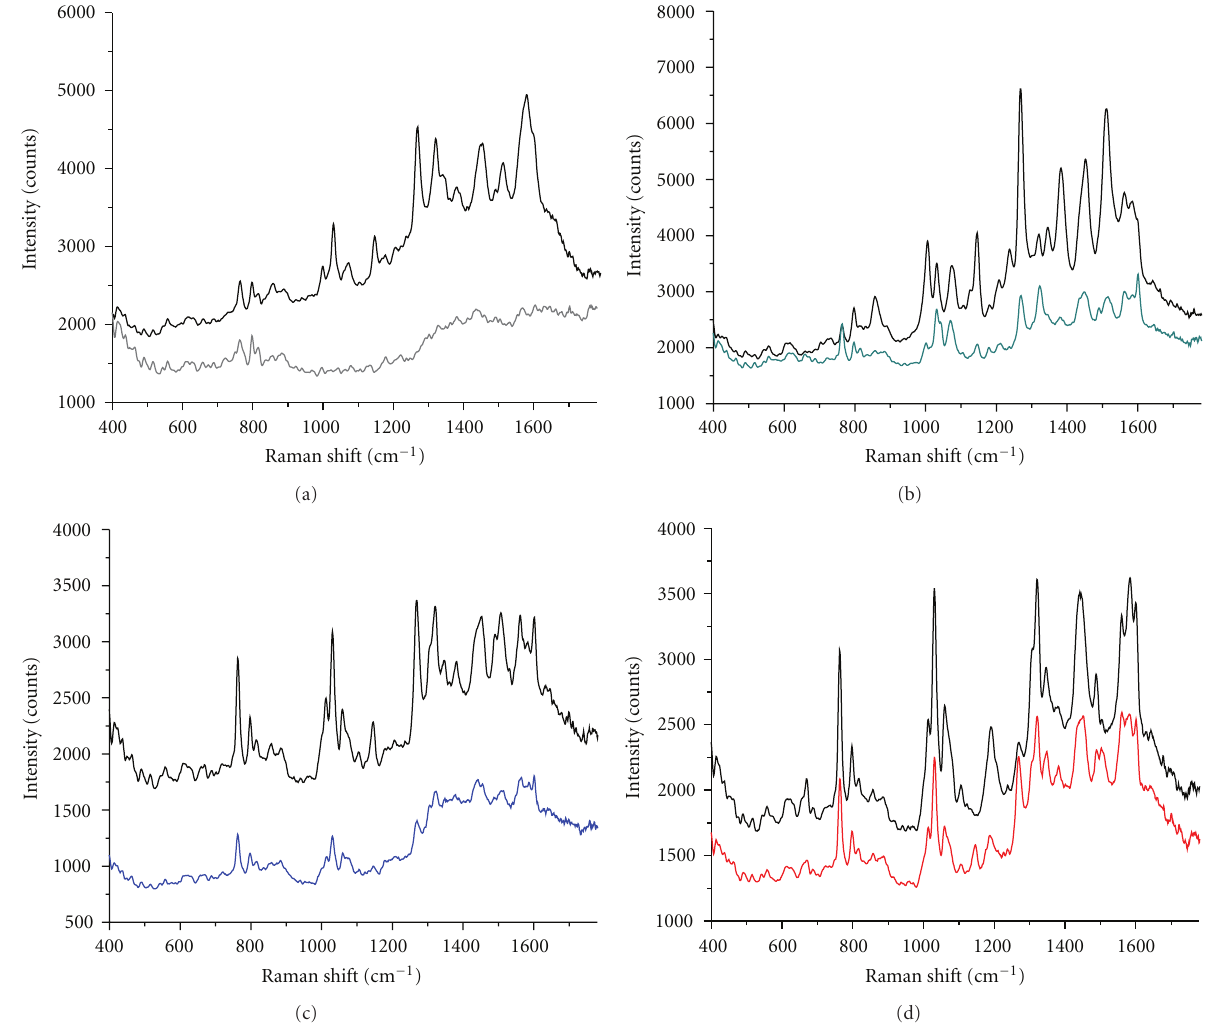
Figure 5: Raman spectrum of gold nanospheres (a) and SERS spectra of PEG-GENs prepared with increasing volumes: 20 μ L (b), 50 μ L (c), and 100 μ L (d) of mPEG-SH polymer, recorded in solution, under NIR excitation. Black spectra are taken in the presence of 1M salted solution while colored spectra represent the spectra of the nano-probes before the addition of